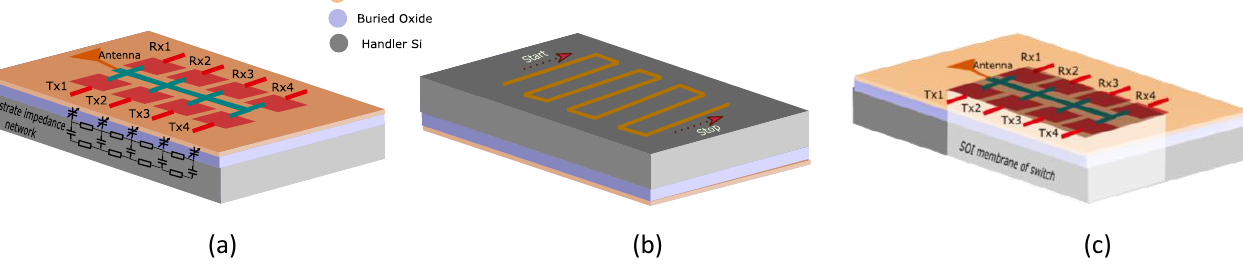
Figure 1. ( a ) Illustration showing the presence of substrate parasitics in RF switch; ( b ) trajectory of laser beam in the milling process to locally remove silicon from the back side; ( c ) SOI membrane of switch showing complete local removal of handler silicon and, consequently, substrate parasitics.